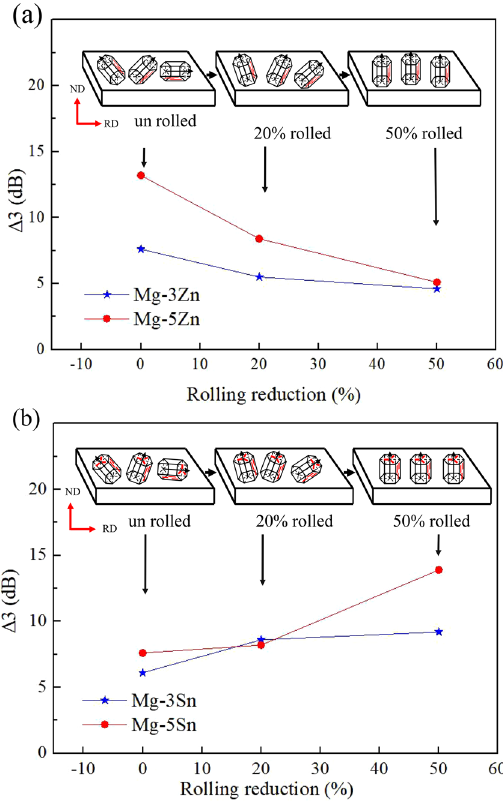
Figure 13. Effect of secondary-phase orientation on the electromagnetic shielding properties of ( a ) Mg-Zn and ( b ) Mg-Sn alloys ( Δ 3 = SE aged (60 h) –SE solutionized ).